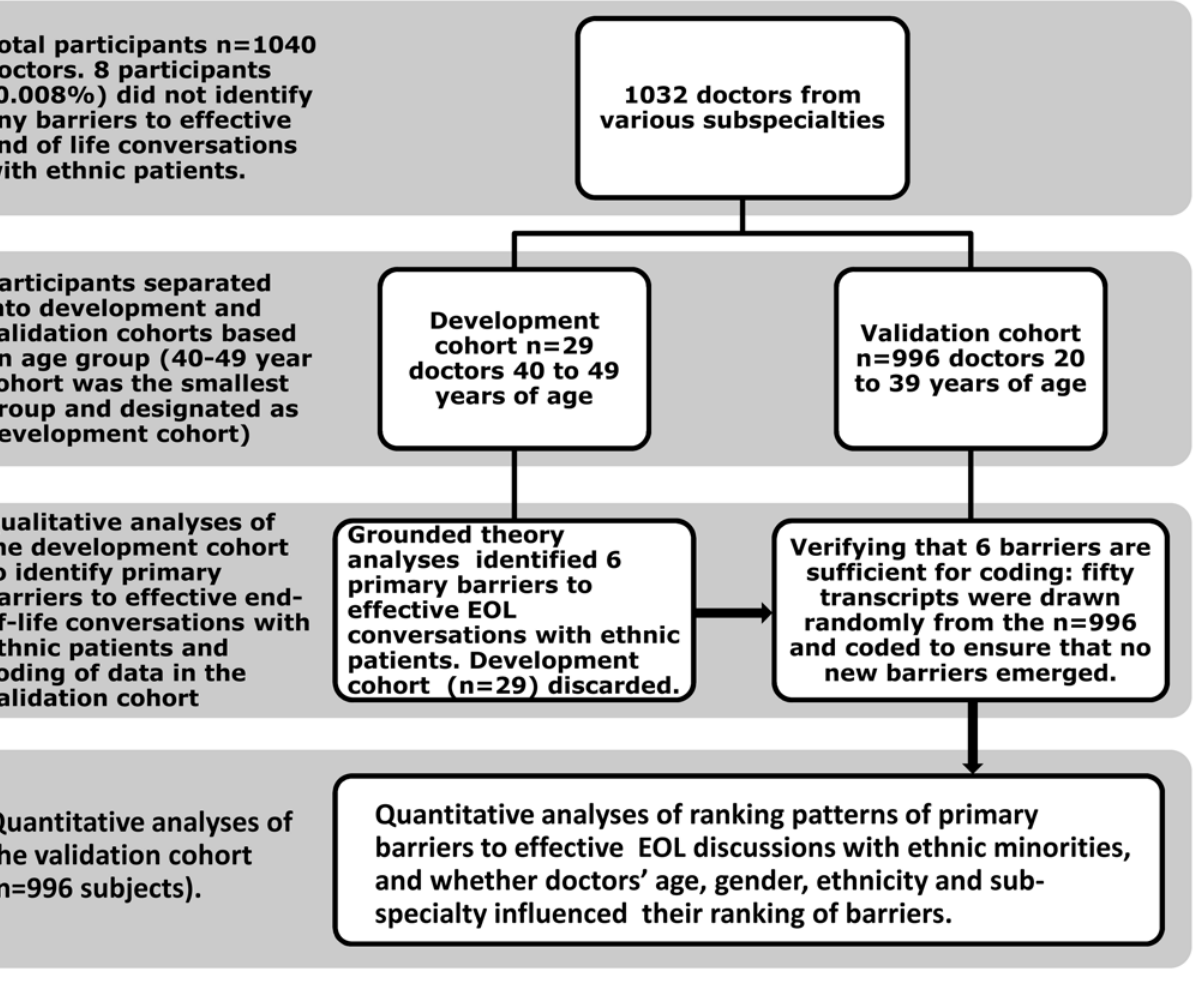
Fig 1. STUDY FLOW: The study subjects were divided into code development and validation cohorts. After identifying the 6 primary barriers using the development cohort, these participants were not used in subsequent analyses. The flow of study participants is shown in the figure.